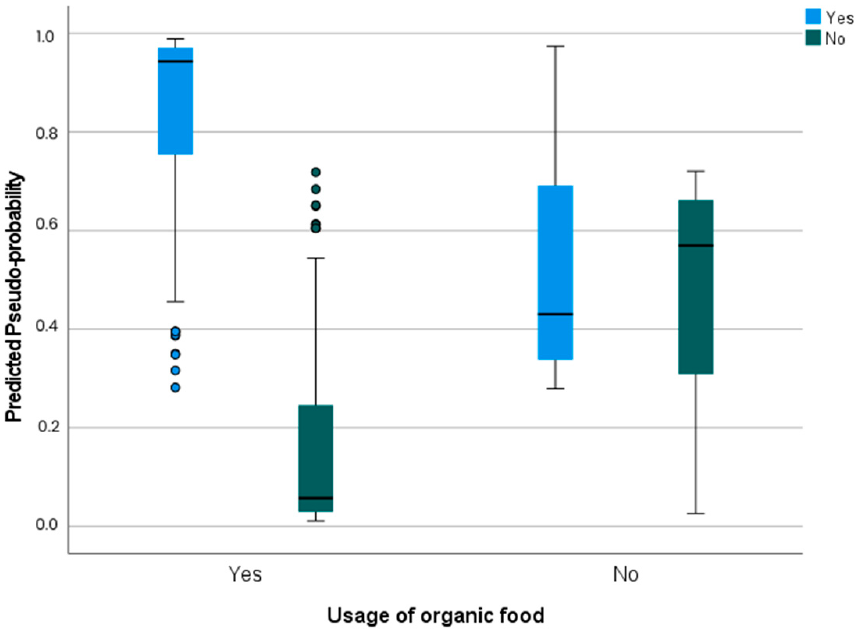
Figure 2. ANN3 models’ pseudo-probabilities presented by a box plot diagram for the variable, usage of organic food; Source: Author’s work, using SPSS. For further validation, an ROC curve has been implemented. It shows the classification performance for all possible cut-offs by a diagram of sensitivity vs. specificity. The area under the curve represents the sensitivity vs. specificity data for the research ANN models and two organic food usage categories in Table 6, which shows the probability of a randomly picked conscript being accurately assessed or ranked if the person is more likely to use organic food. This interpretation is based on the non-parametric Mann–Whitney U statistics test used for the area under the curve computation. Furthermore, the maximum area under the curve = 0.876 (ANN1) was followed by ANN3 (area under the curve = 0.856), which demonstrated that the model has a good predictive standpoint for perceiving the organic food usage among the population Republic of Croatia. The maximum value for the area under the curve is equal to